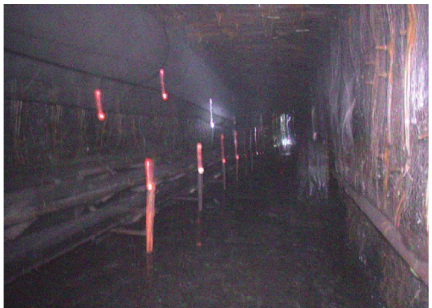
Figure 23: The stable environment of surrounding rock in 8103